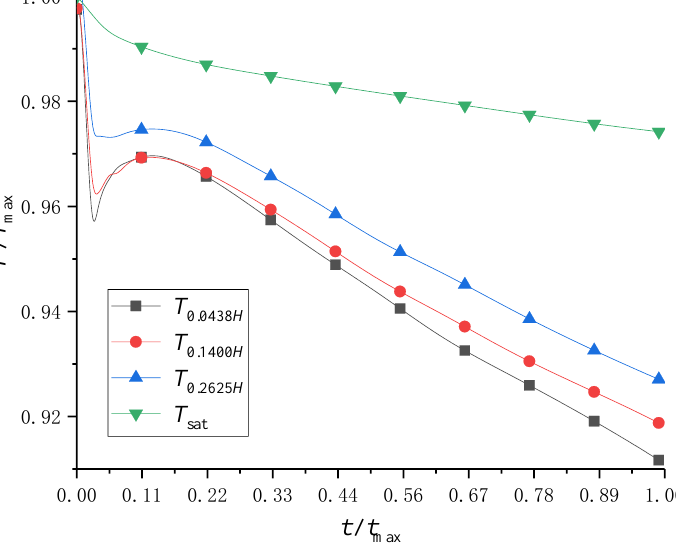
Figure 4. The variation of temperature at different heights of the steam generator in experiment. Referencing the value at 0 s, the water temperature at the tube bundle area of the steam generator was almost equal to the saturation temperature in normal operation. There was no thermal stratification phenomenon. This was because the feedwater was quickly heated to saturation temperature in the feed pipes and the descending channel by convection heat transfer. After the loop stopped operation, the feedwater leaked into the secondary side of the steam generator. However, the convection heat transfer was not sufficient to heat the feedwater to saturation and the water temperature at the bottom of the secondary side of the steam generator dropped rapidly. Finally, there was a large difference between the saturation temperature and the water temperature at the bottom of the secondary side of the steam generator. At this time, the value of Ri was approximately 27,000 and the thermal stratification phenomenon occurred. After turning off the feedwater valve, the water temperature at the secondary side rose. This was because the primary coolant conducted heat to the water at the secondary side of the steam generator, which caused the temperature difference to narrow and the thermal stratification phenomenon to be weakened. Then, in the process of natural cooling, the pressure and temperature at the secondary side of the steam generator kept decreasing slowly, but the water temperature at the bottom of the secondary side of the steam generator decreased faster than the saturation temperature. Therefore, the temperature difference became larger and larger, and the thermal stratification phenomenon became more and more obvious. After 5 h of natural cooling, there was still an obvious thermal stratification phenomenon. At this moment, the coolant temperature at the bottom of the steam generator was much lower than the saturation temperature and the temperature measured at the reactor inlet or reactor outlet. The operator was unable to determine the coolant temperature at the bottom of the steam generator from the available measured parameters. Therefore, an analysis of the